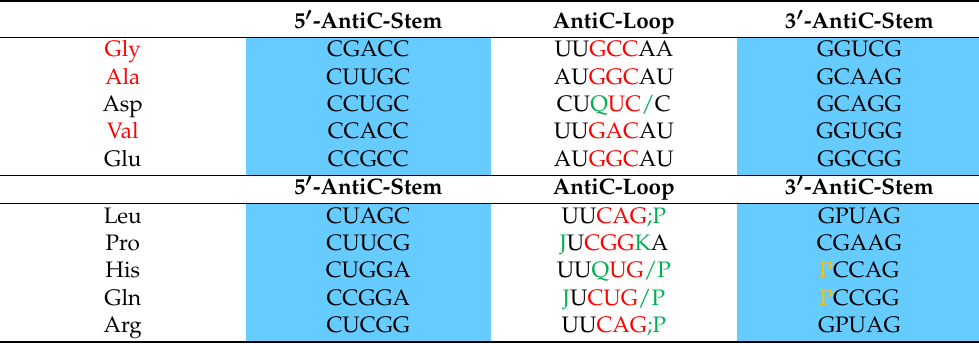
Table 3. Base sequences of E.coli anticodon stem loops (AntiC-SLs) decoding GNC codons to [GADV]- amino acids. Bases chemically modified are shown with green or brown bold letters or green symbols as “;” and “/”, which are quoted from the tRNA database [19]. It is supposed that those chemically modified bases around anticodon play roles in protruding anticodon from AntiC-loop and in assisting of binding of the anticodon (written in red bold letters) with the codon. Base sequences of five AntiC- SL RNAs, which are used for translation to GNS-encoding five amino acids are given in upper table. Three amino acids, Gly, Ala, and Val, having no chemically modified base, are written in red bold letters Base sequences of five AntiC-SL RNAs, which are used for translation of five C-start codons-encoding five amino acids, Leu, Pro, His, Gln, and Arg, are given in lower table. 5 (cid:48) -AntiC-Stem